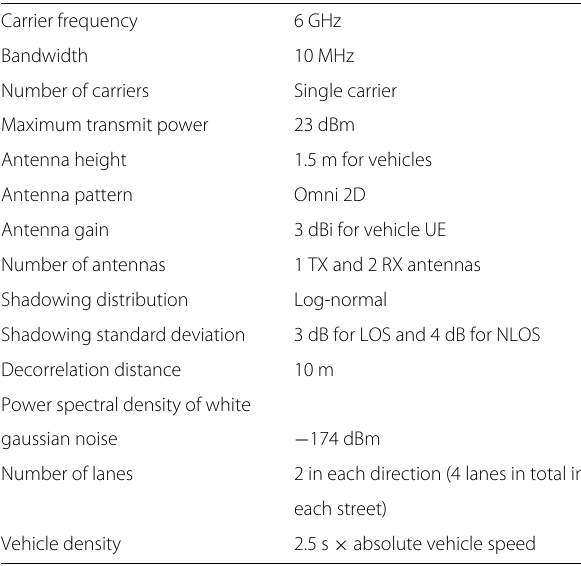
Table 4 Simulation parameters